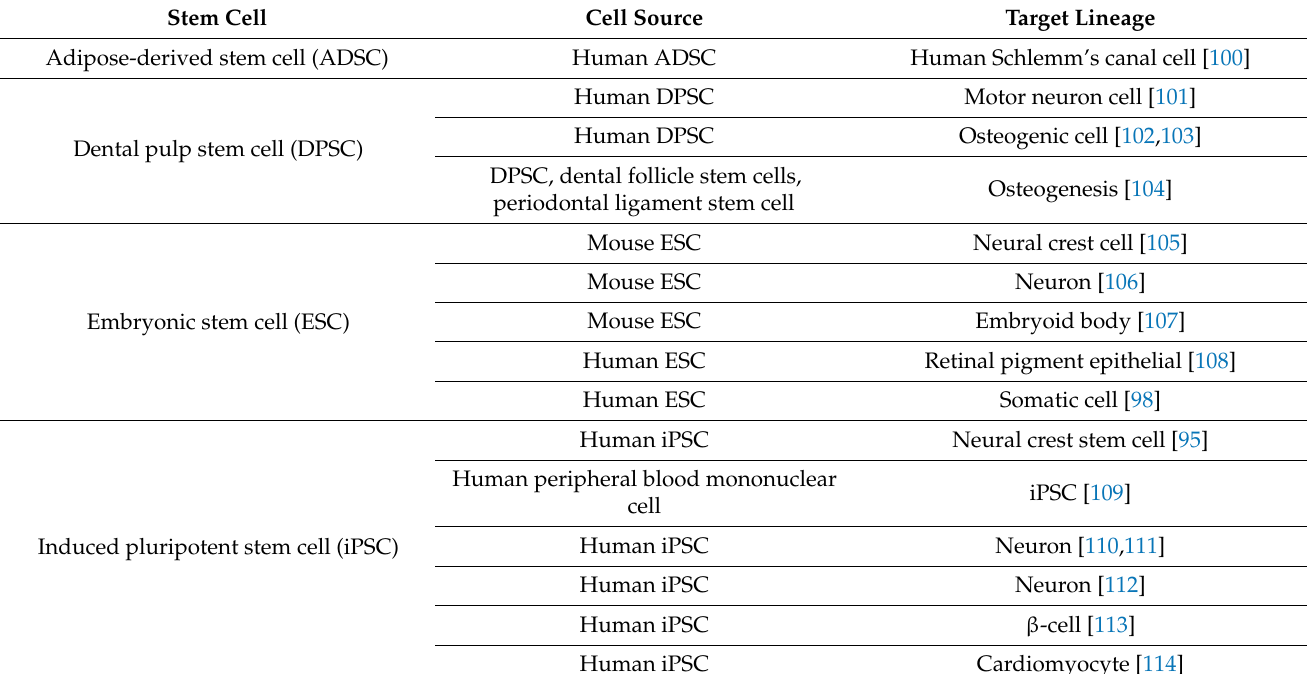
Table 1. Recent studies related to stem cell differentiation using immunocytochemistry. Stem